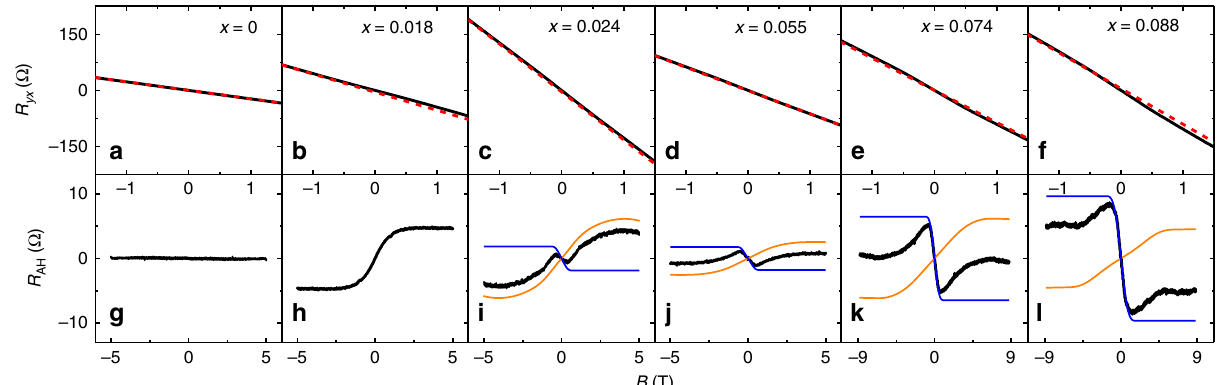
Fig. 2 Evolution of the Hall effect and the corresponding AH resistances with increasing Mn concentration. Shown in panels a – f and g – l are the magnetic fi eld dependences of the Hall resistance R R B ) = R B ) − R B ), respectively, for Mn concentrations yx and the nonlinear part of the Hall resistance ( yx ( AH ( H x = 0 – 0.088 at T = 1.6 K. For doped samples ( x > 0), the nonlinear Hall resistances predominantly originate from the AH effect. For the undoped sample ( x = 0), it is nearly zero. Here the R H values are obtained by linear fi ts of the raw R yx ( B ) curves with magnetic fi eld ranges 3 – 5 T for samples with x = 0 – 0.055 and 5 – 9 T for samples with x = 0.074 and 0.088. With the methods described in the Supplementary Information, the AH resistance R AH is then separated into a positive component (orange line) and a negative one (blue line) for the samples with x >